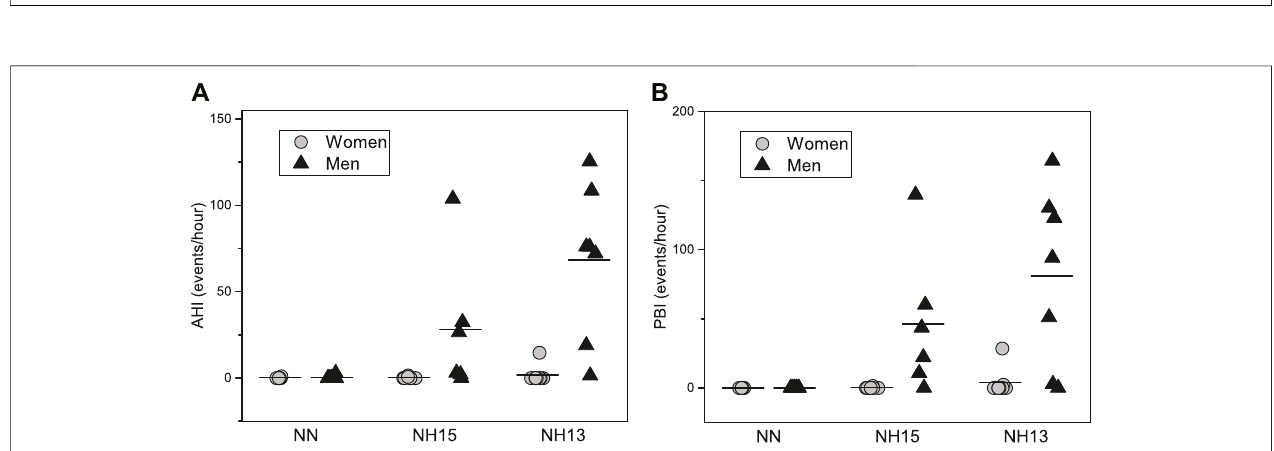
FIGURE4| Apnea-Hypopnea Index (AHI) (A) and PeriodicBreathingIndex(PBI) (B) duringa90 minnapundernormoxic(NN) andhypoxicconditions(NH15:FiO 2 14.7, NH13: FiO 2 12.5) in healthy men ( n = 7) and women ( n = 8).